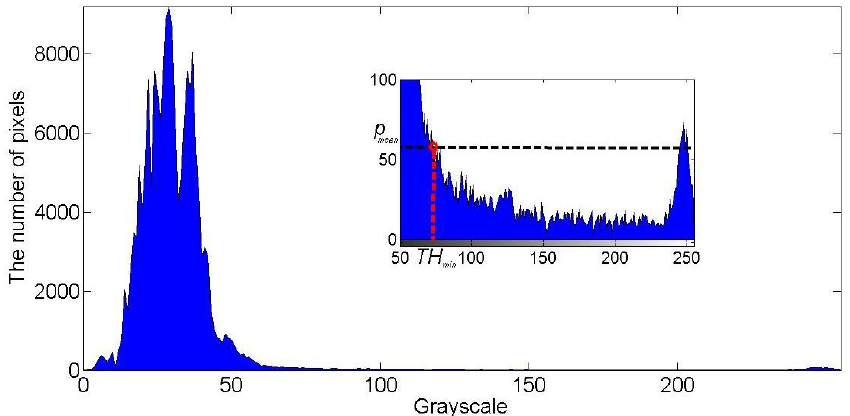
Figure 2. Histogram of the ROI in a typical image of a nighttime traffic